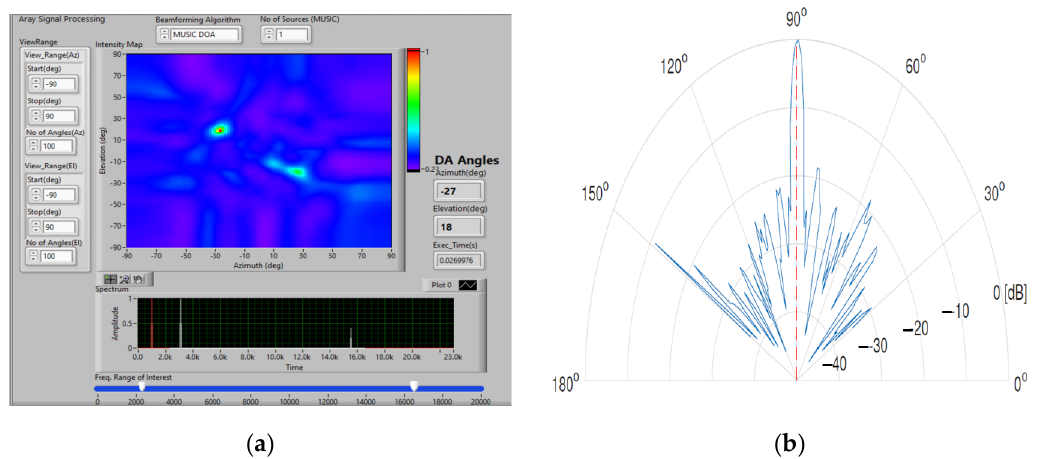
Figure 12. Simulation square microphone array and beamforming using acoustic frequency charac- teristic of UAVs ( a ) and directivity characteristic ( b ).